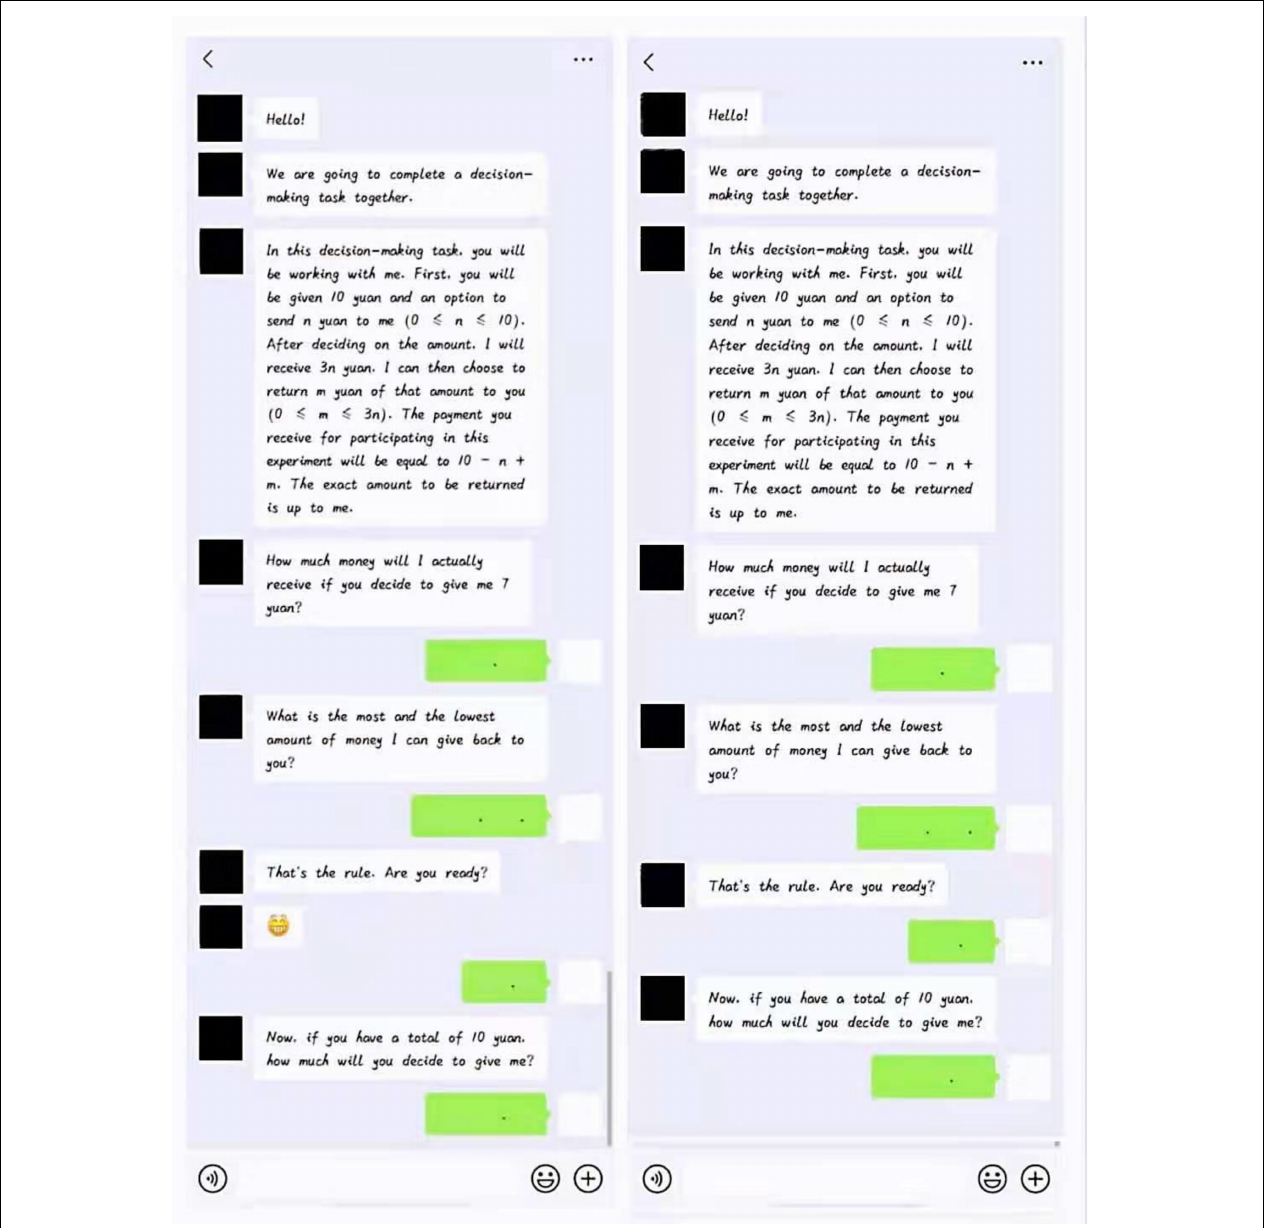
FIGURE 1 | Two groups of college students playing the trust game in a WeChat dialogue box.